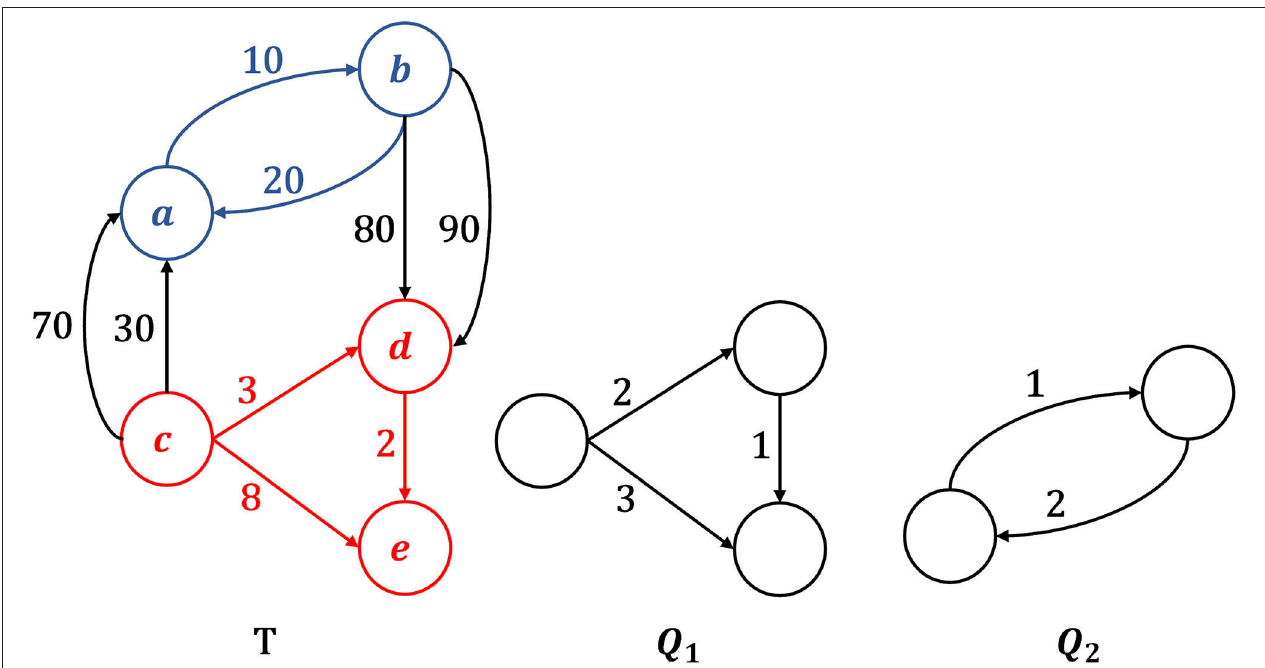
FIGURE 1 | Example of motif 1 -occurrence in a temporal graph T , given 1 = 6. Motif Q 1 has exactly one 1 -occurrence in T , which is the subgraph formed by nodes and edges colored in red. Motif Q 2 , instead, does not 1 -occur in T . In fact, the subgraph with blue nodes and blue edges is isomorphic to Q 2 and respects the chronological order imposed by Q 2 ’s edges, but its edges are not observed within the time window 1 .